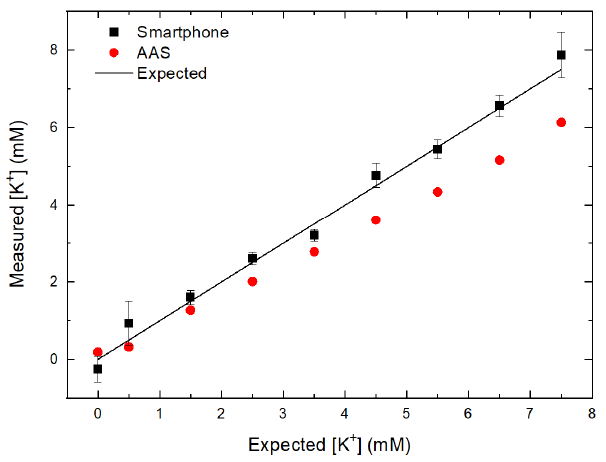
Figure 7. Plot of [K + ] in blood samples obtained by smartphone device and AAS instrument.